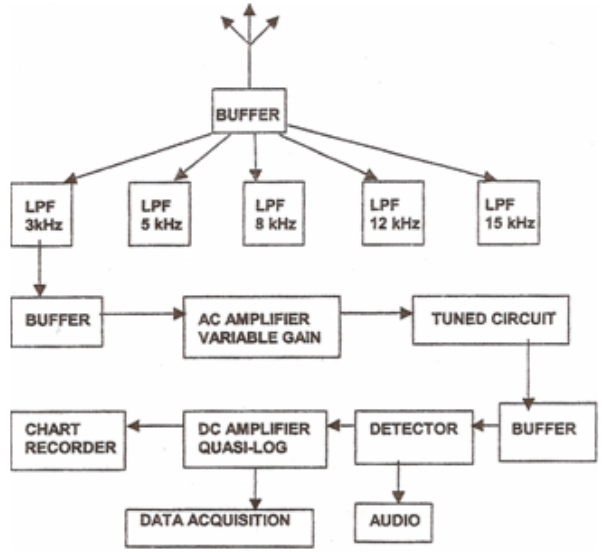
Fig. 2. Flow chart of the ELF-VLF receiving system at Agartala (Lat. 23 ◦ N, Long. 91.4 ◦